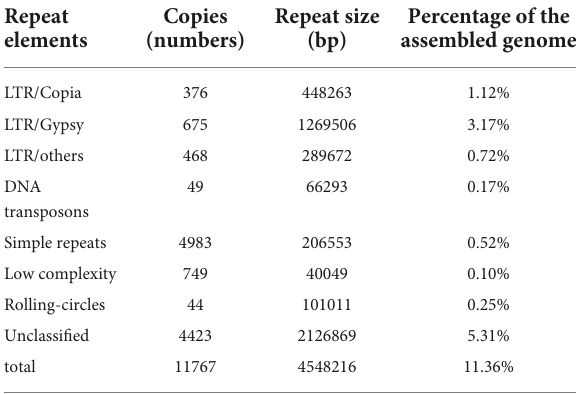
TABLE 2 Repeat element analysis in the Pleurotus giganteus genome.